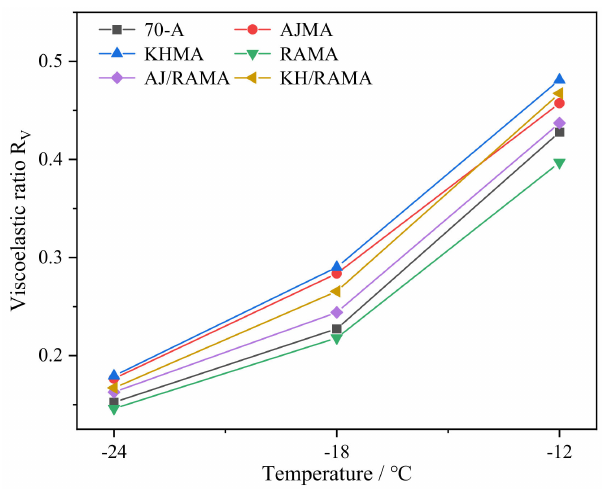
Figure 13. Viscosity elasticity ratio of asphalt at low temperature R V